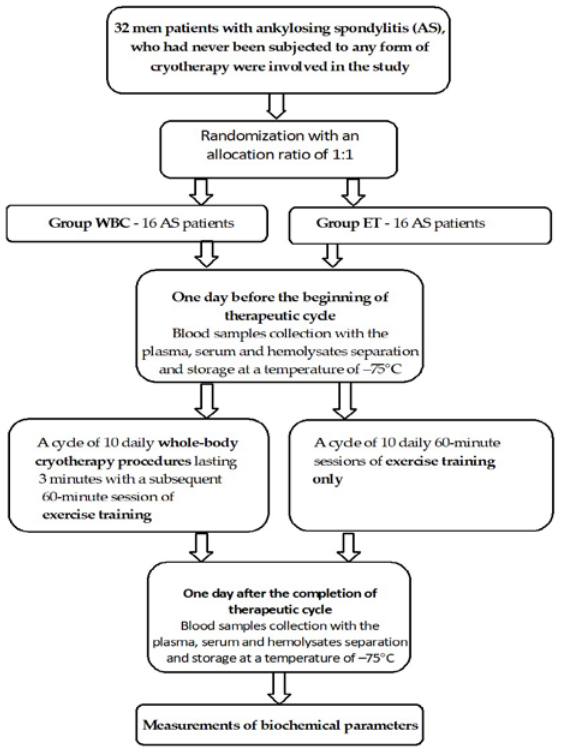
Figure 1. Scheme of study protocol.